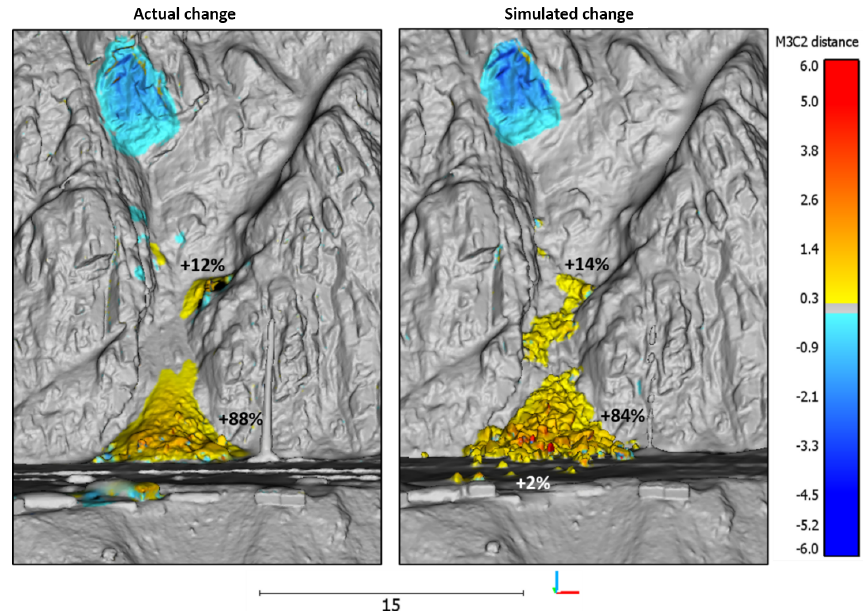
Figure 14. A comparison of the actual and simulated change detection results from the 24m 3 wedge sliding event from White Canyon East, Site B. The simulation produced a good comparison with the actual change results, yielding a similar spatial distribution, and magnitude of change. The percentage of initial source volume retained at various locations on the actual and simulated slope is shown. In this case the majority of the material in both the actual and simulated analysis ends up in the track-side ditch, with a smaller component of the volume stopped inside the gully. In the simulated change a small number of fragments do reach track level, representing approximately 2% of the simulated